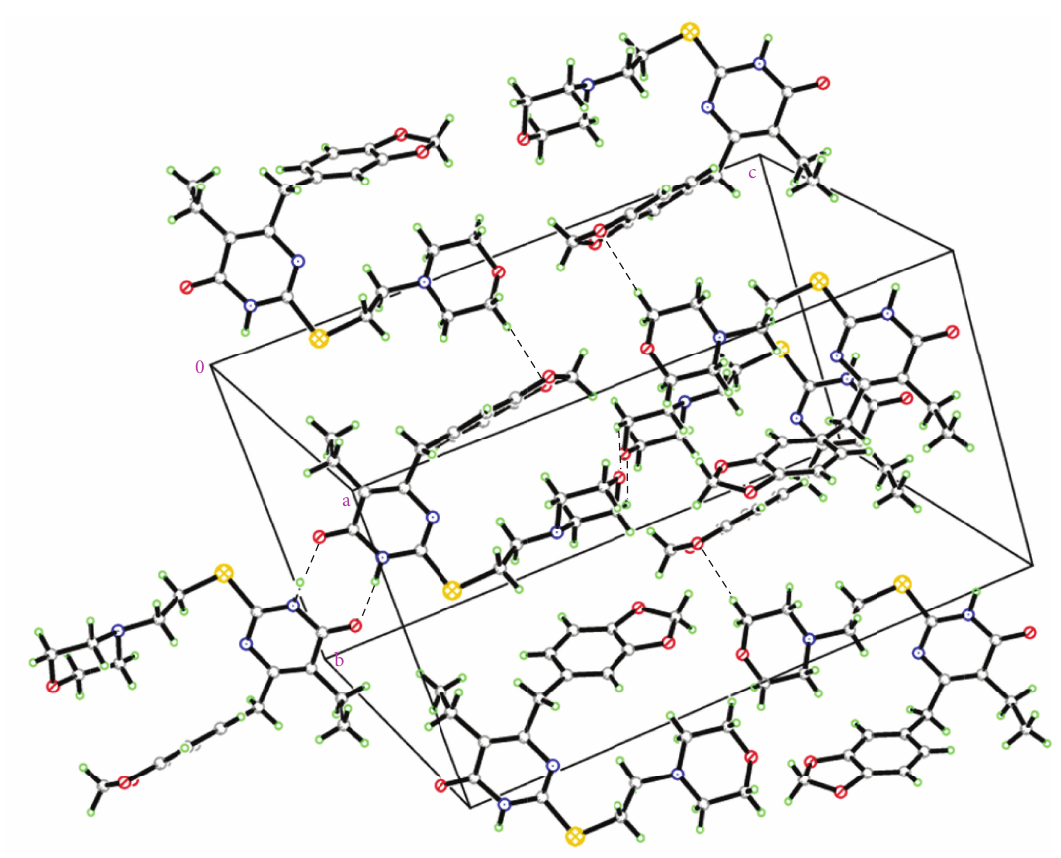
Figure 2: Crystal packing showing intermolecular C–H ⋅⋅⋅ O hydrogen bonds as dashed